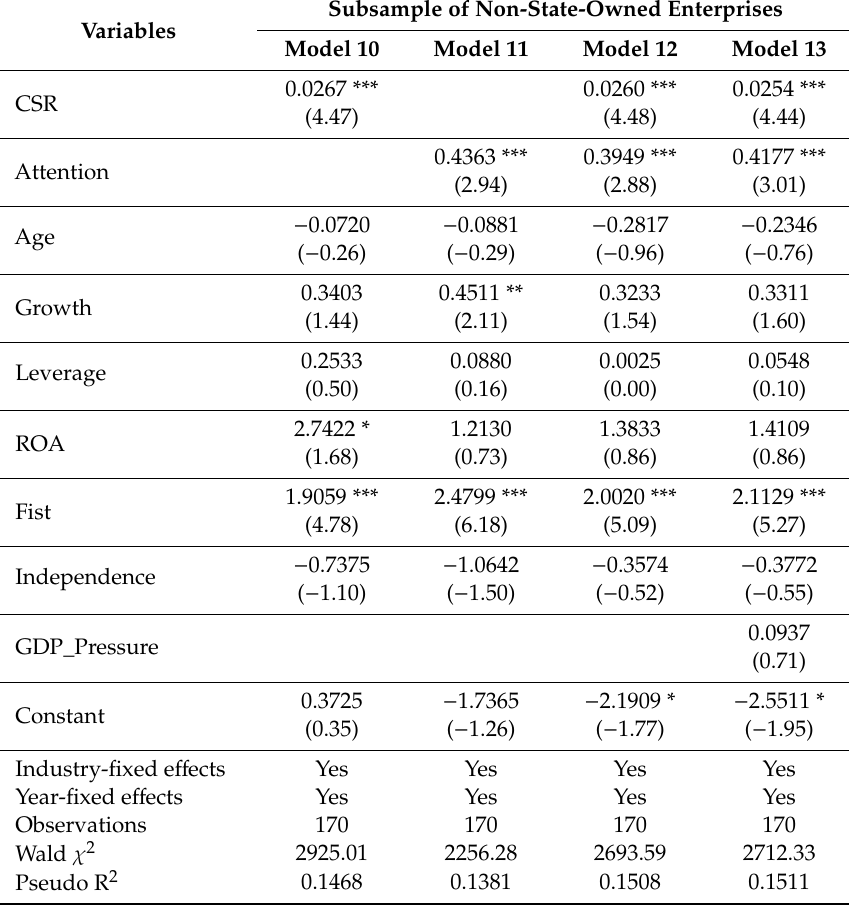
Table 6. The Regression Results of Non-State-Owned